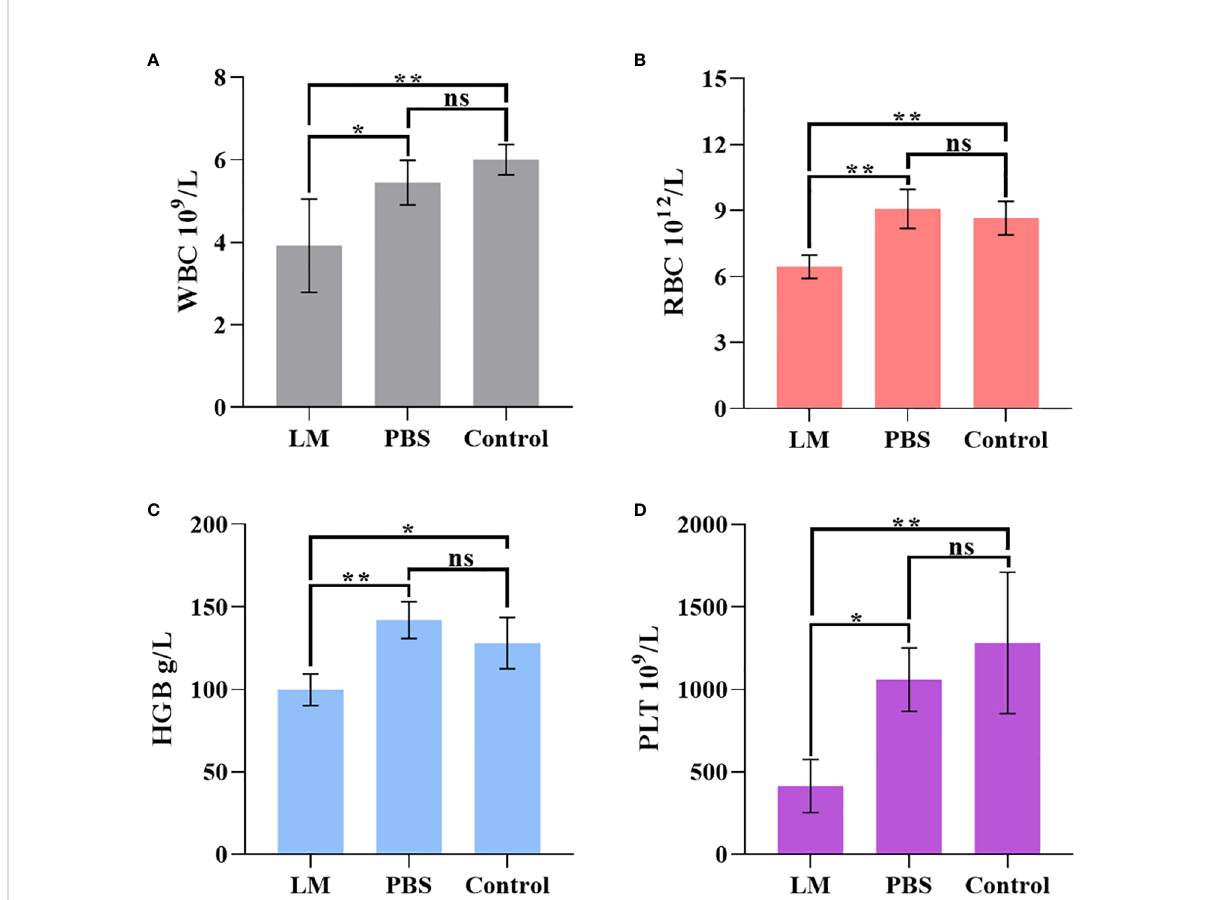
FIGURE 8 The statistical results of group comparison in haematology tests. (A-D) represents the expression level of WBC, RBG, HGB, PLT in three groups, respectively. LM, liquid metal; PBS, phosphate buffer saline; WBC, blood cell count; RBC, Red blood cell count; HGB, Hemoglobin; PLT, Platelet count; *, indicates P<0.05; **, indicates P<0.01. ns, indicates no signi fi cant